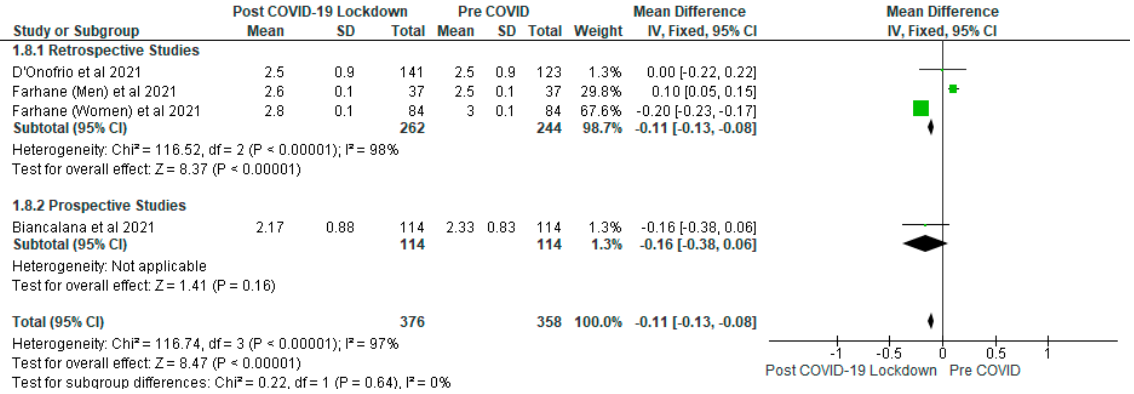
Figure 8. The effect of COVID-19 lockdown on LDL Cholesterol (mmol/L). For total cholesterol (mmol/L), the mean difference was − 0.53 (95% CI: − 0.56, − 0.50). Three studies were included in this analysis, with 734 participants (post-COVID-19 lock- down gp, n = 376; pre-COVID gp, n = 358). The subgroup meta-analysis showed that although there were significantly ( p < 0.05) lower total cholesterol in the post-COVID-19 lockdown gp compared with pre-COVID gp in relation to the retrospective studies, the difference was not significant ( p > 0.05) in the prospective study. With respect to triglyceride (mmol/L), the mean difference between the post-COVID- 19 lockdown gp and pre-COVID gp was − 0.06 (95% CI: − 0.09, − 0.04), involving 3 studies and 734 participants (post-COVID-19 lockdown gp, n = 376; pre-COVID, n = 358) (Figure